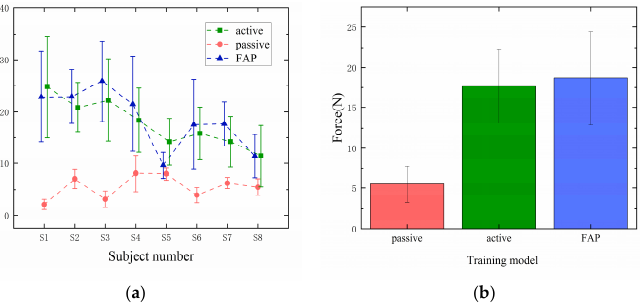
Figure 15. ( a ) Comparison of robot end force sensor values for eight subjects in different training modes . ( b ) Group average of force sensor values for eight subjects in different modes .